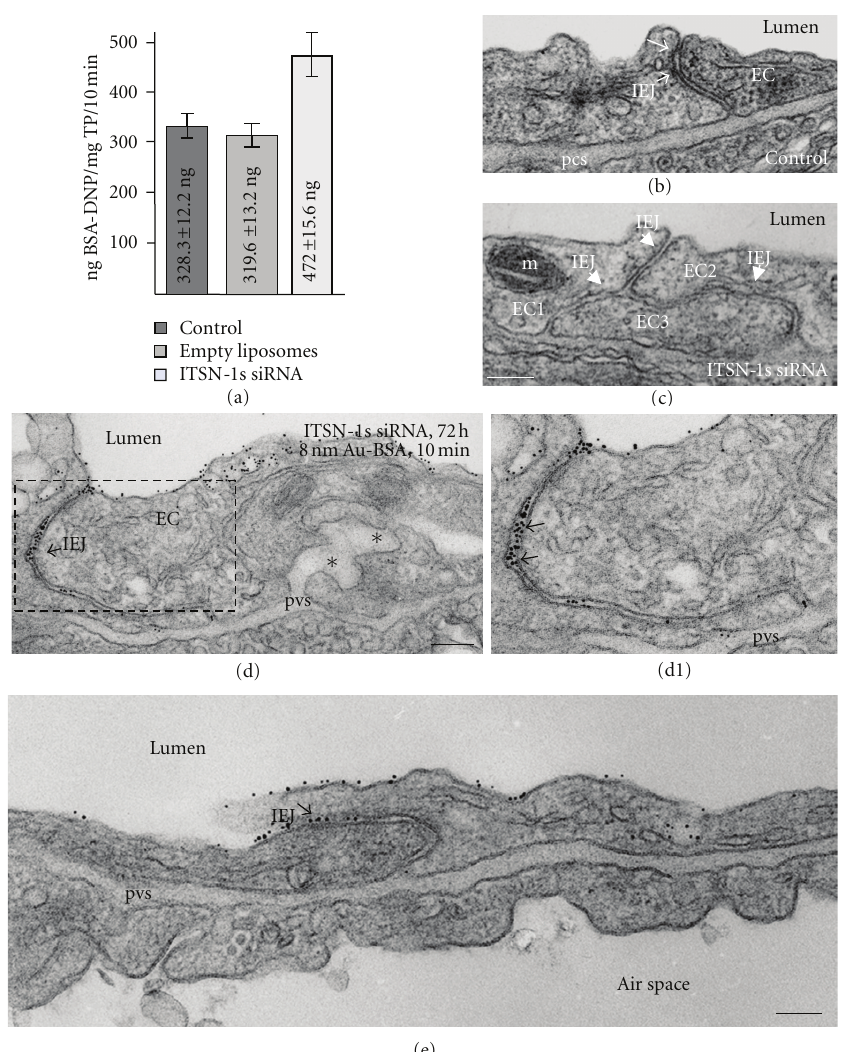
Figure 3: Increased endothelial permeability and impaired interendothelial junctional integrity in mouse lung endothelium acutely depleted of ITSN-1s. (a) ELISA applied on mouse lung lysates of control, empty liposomes, and ITSN-1s siRNA-treated mice, (72h alter siRNA), perfused with 10 mg/mL BSA-DNP, for 10 min. Results were obtained in 4-5 di ff erent experiments, (3 mice/experimental condition), and expressed in ng BSA-DNP/mg total protein/10min. Bars ± SD. (b, c) EM morphology of IEJs in control (b) and ITSN-1s siRNA (c) mouse lung endothelium. Arrows in B point to the dense protein matrix of the tight junctions sealing the interendothelial space. Arrowheads in (c) point to three open IEJs. EC: endothelial cell; m: mitochondria. Bar: 150 nm. (d, e) Representative electron micrographs showing open IEJs labeled throughout their length by 8 nm Au-BSA particles. Arrows in (d) and magnified d1, point to three-four Au-BSA particles located close to each other in the same plan, indicative of the wide opening of the IEJ. Gold particles are also associated with the abluminal exit of IEJs. Note also the limited number of caveolae and dilation of the pericapillary space (pcs; asterisks). Bars: 200 nm (d); 100 nm